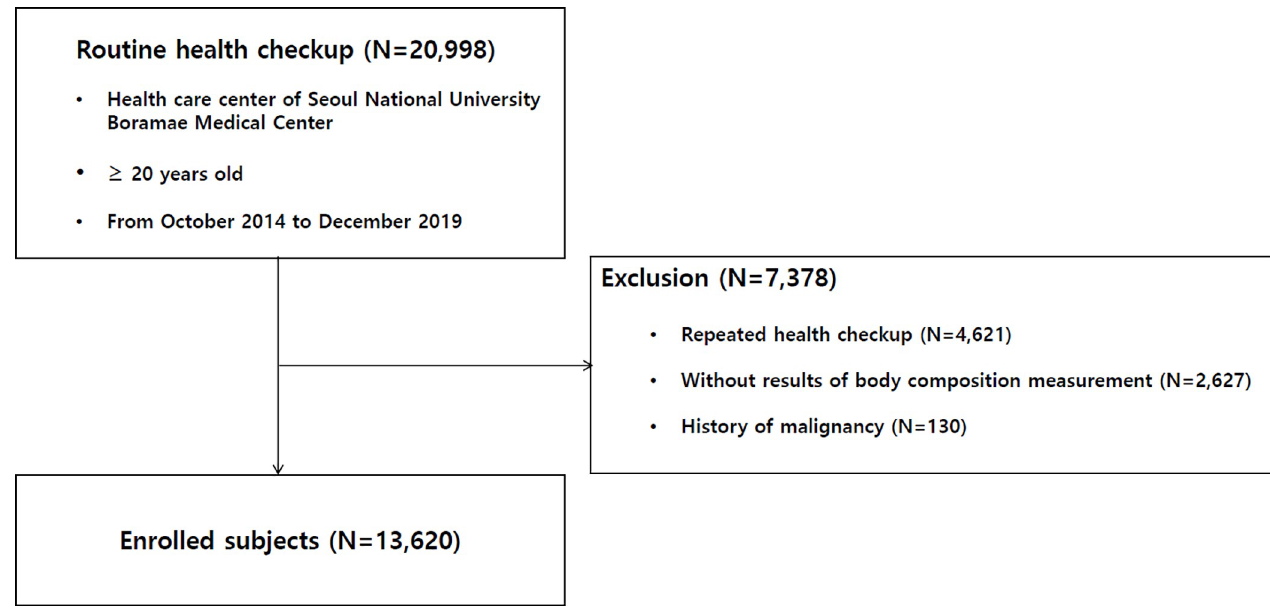
Fig 1. Enrollment flow chart of